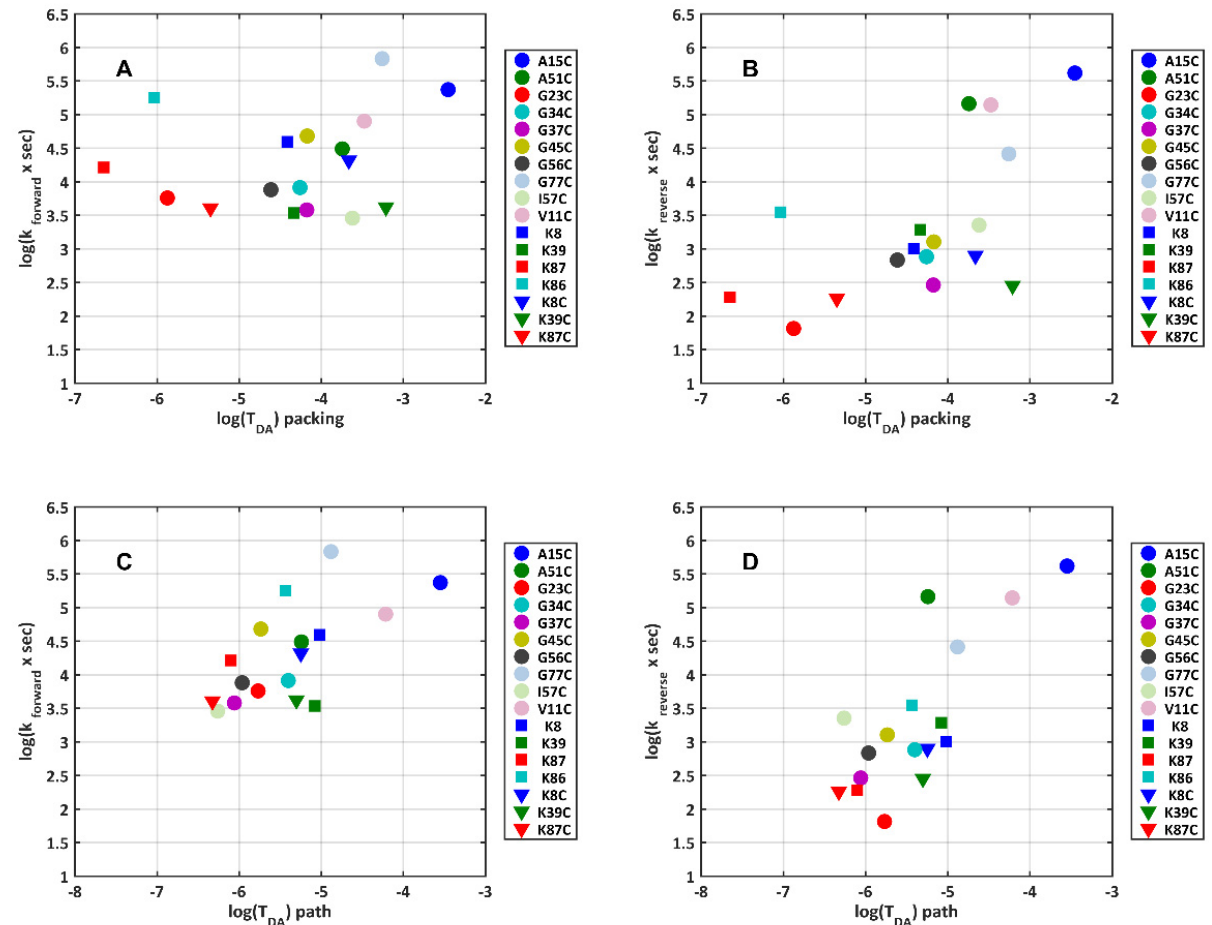
Figure 6. Forward and reverse electron transfer rates calculated using Scheme 1 from multichannel absorption kinetic measurements performed at room temperature. Rates are shown versus the dimensionless pathway or packing density coupling terms between the edge of the heme ring structure and the terminal atom of the labeled amino acid, calculated with HARLEM, using the structure 1HRC.pdb. ( A , B ) Forward and reverse rates, respectively, plotted versus the coupling term, T DA calculated with the packing density model (Equation (3)); ( C , D ) forward and reverse rates, respectively, plotted versus T DA calculated with the pathway model (Equation (4)).